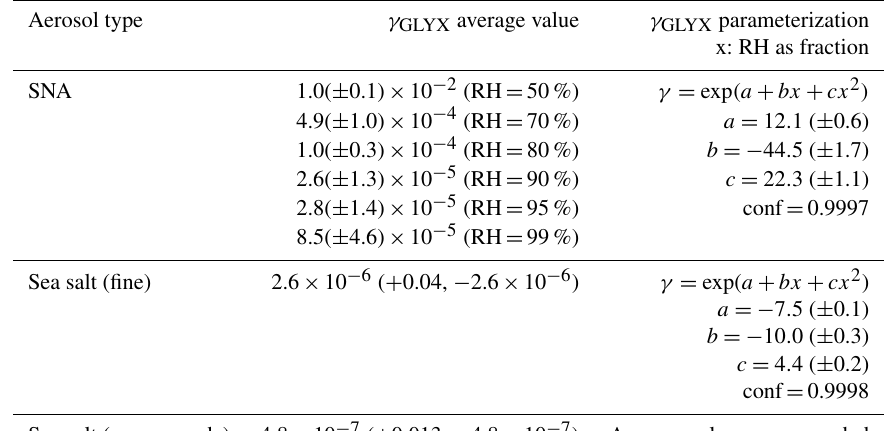
Table 4. Summary of γ GLYX recommendations for aerosols. Aerosol types and specifications as defined in GEOS-Chem v11.